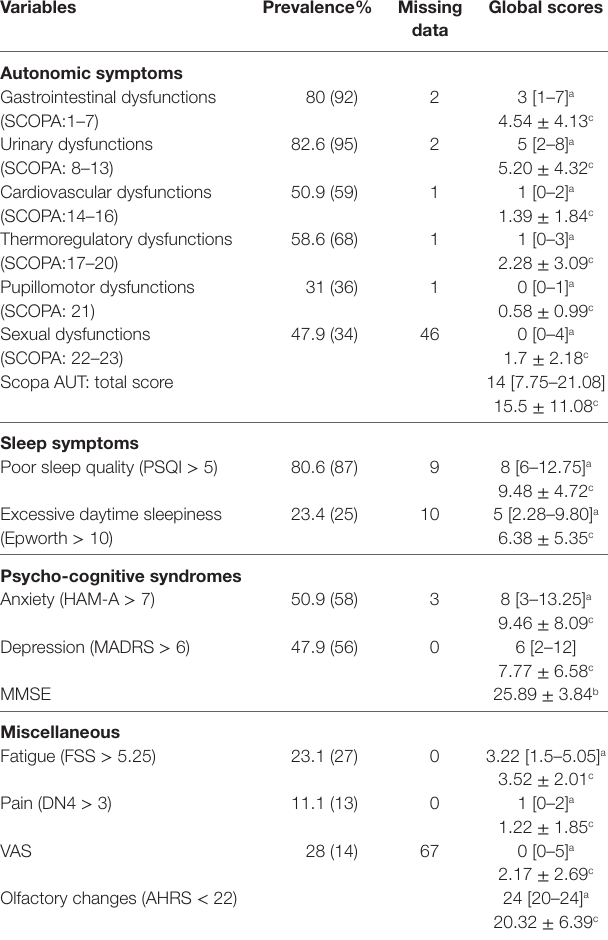
TaBle 2 | Prevalence of non-motor features of Parkinson’s disease (PD) patients. Variables Prevalence% Missing